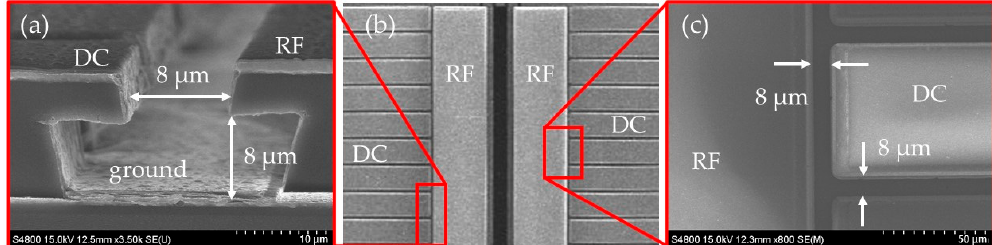
Figure 1. Examples of small gaps between the radio frequency (RF) electrode and adjacent electrodes. ( a ) Cross-section of a surface trap, ( b ) typical layout of electrodes in a surface ion trap, and ( c ) typical gaps between electrodes. All scanning electron microscope (SEM) pictures were taken of the surface ion trap introduced in reference [27].